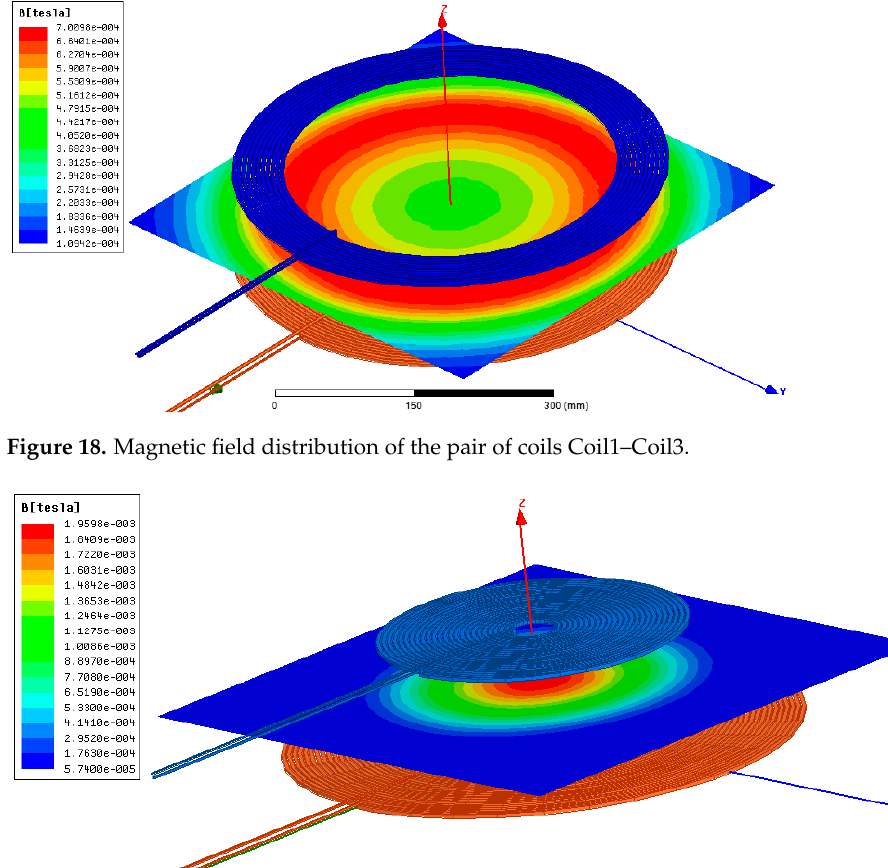
Figure 20. Fabricated coils: ( a ): Coil1, ( b ): Coil2 and ( c ): Coil3.